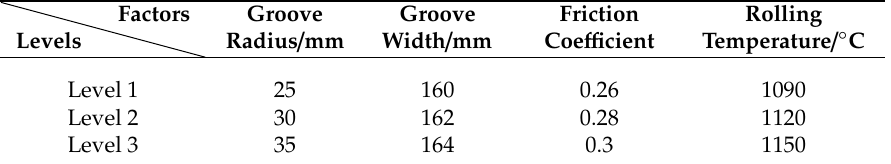
Table 5. The simulation results using the orthogonal test method.